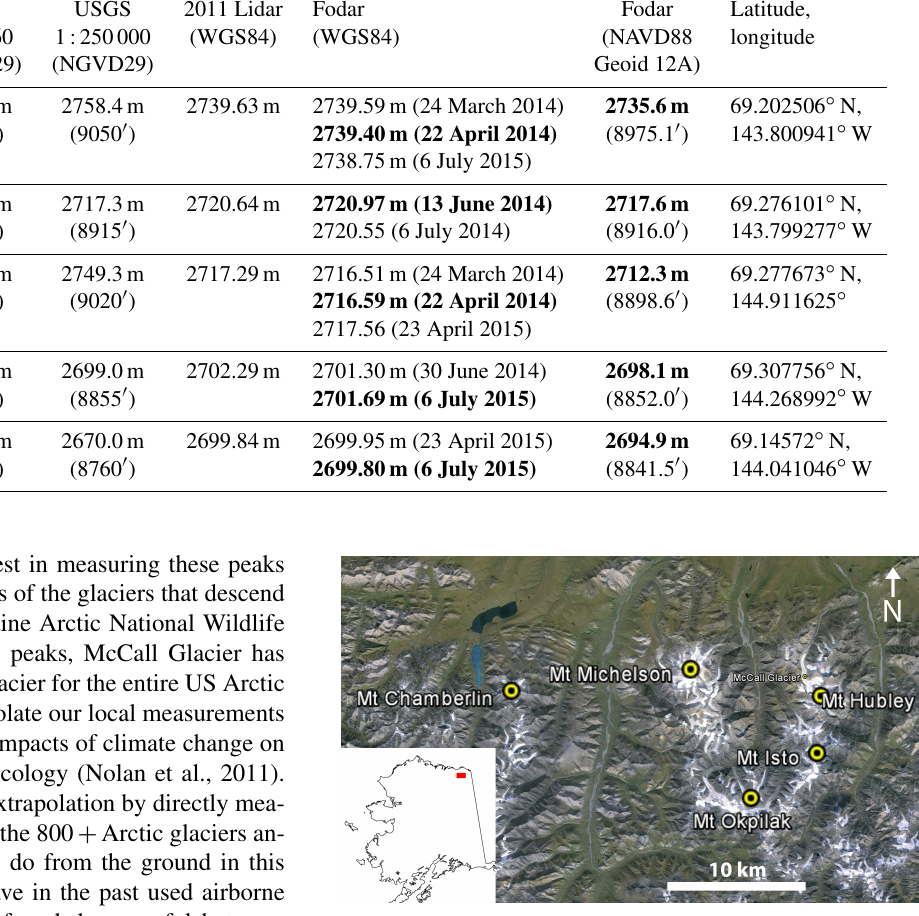
ating maps with 10–20 cm ground sample distances